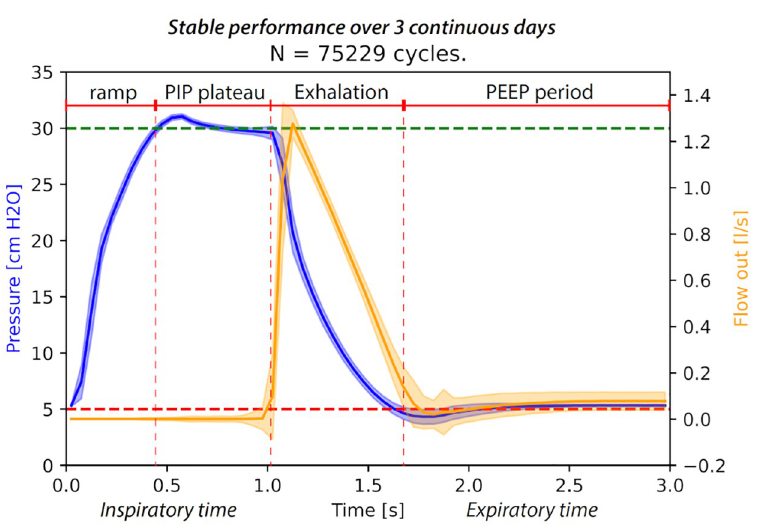
Fig 2. Example of a PVP1 breath waveform. Overlaid pressure control breath cycle waveforms for airway pressure and flow out over 70,000+ cycles, breathing into a Quicklung lung model. Test settings: compliance C = 20 mL/ cmH 2 O, airway resistance R = 20 cmH 2 O/L/s, PIP = 30 cmH 2 O, PEEP = 5 cmH 2 O. Shaded areas indicate variability (standard-deviation) over the entire test period.